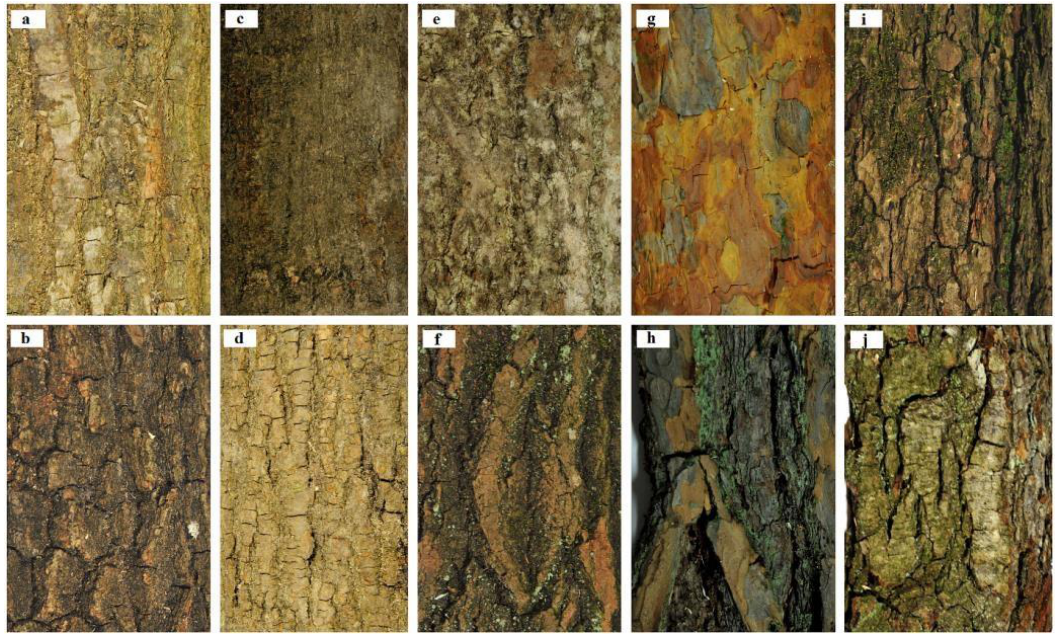
Figure 1. Samples of bark collected from the height 1.5 ( b , d , f , h , j ) and 15 m above ground level ( a , c , e , g , i ) for five selected tree species: oak ( a , b ), ash tree ( c , d ), aspen ( e , f ), pine ( g , h ), and alder ( i , j ).